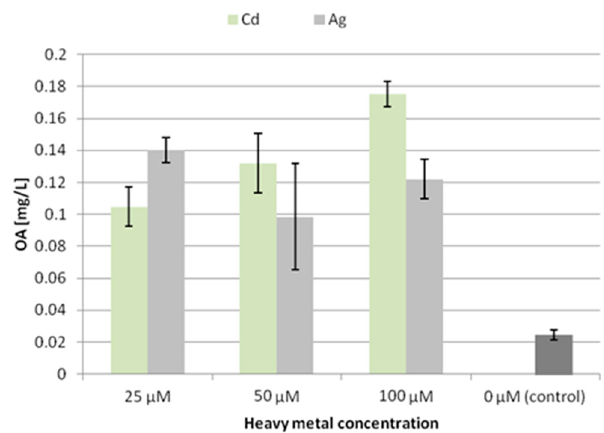
Figure 5. The content of oleanolic acid in the medium (CH2 line) after elicitation with silver and cadmium ions. OA—oleanolic acid.